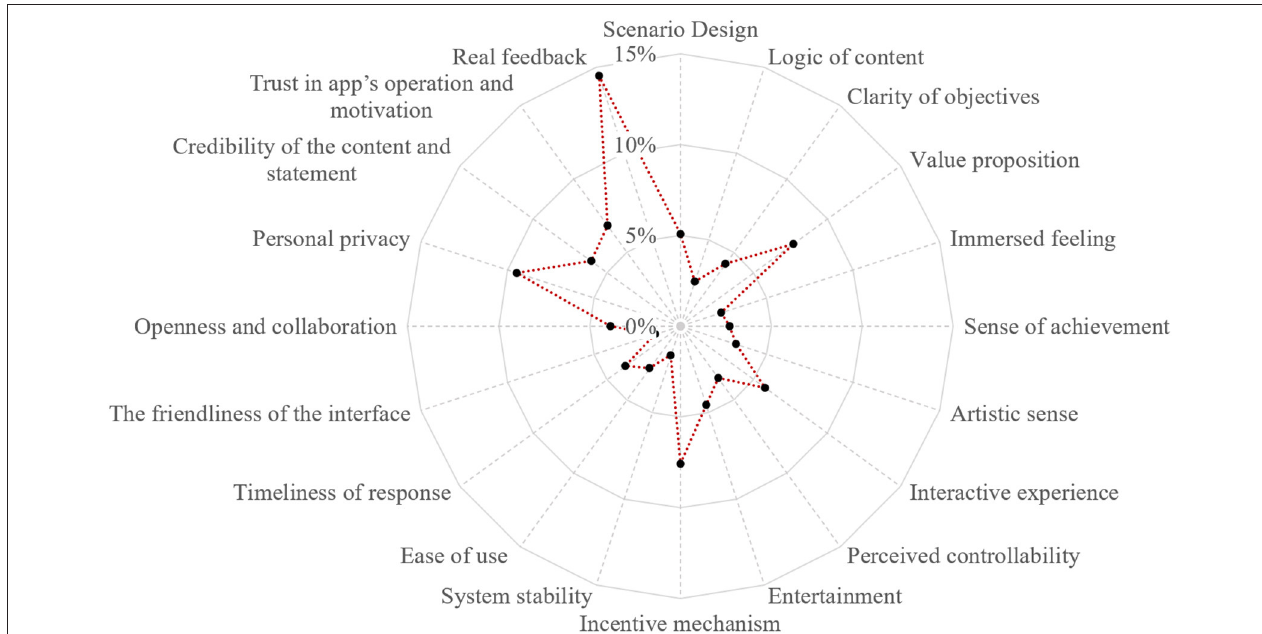
FIGURE 4 | Gamification design evaluation index weights for sustainable consumption